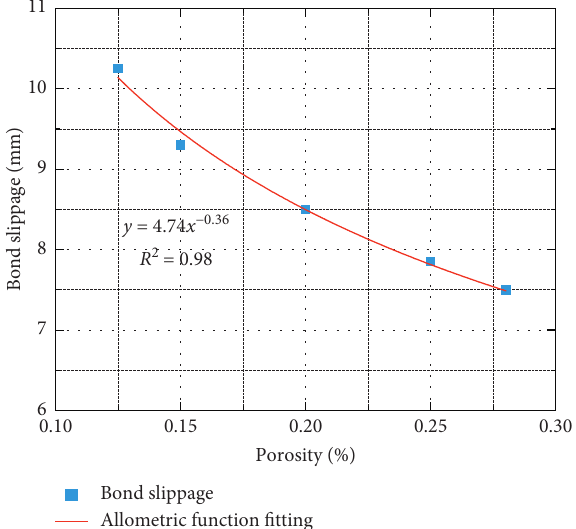
Figure 15: The relationship between porosity and bond